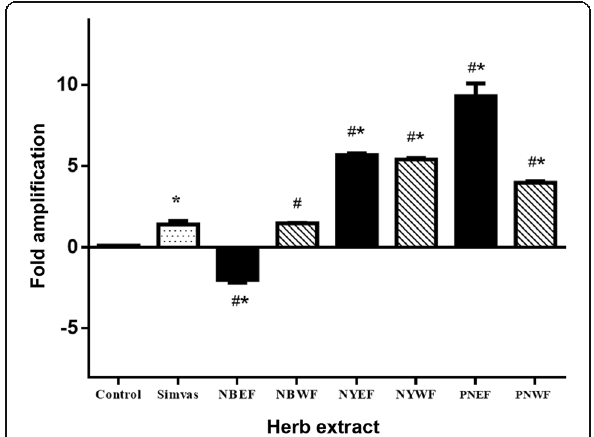
Fig. 5 Effect of all extractions on LDL-R gene expression: NBEF, NBWF, NYEF, NYWF, PNEF and PNWF (1 mg/ml each) were individually added to the cells. The expression of LDL-R in HepG2 cells was compared with that in the presence of 1 mg/ml simvastatin and 0.5% DMSO as positive and negative controls, respectively. Bars represent the mean± SD of independent triplicate experiments. # p <0.05 compared with the negative control * p <0.05 compared with simvastatin